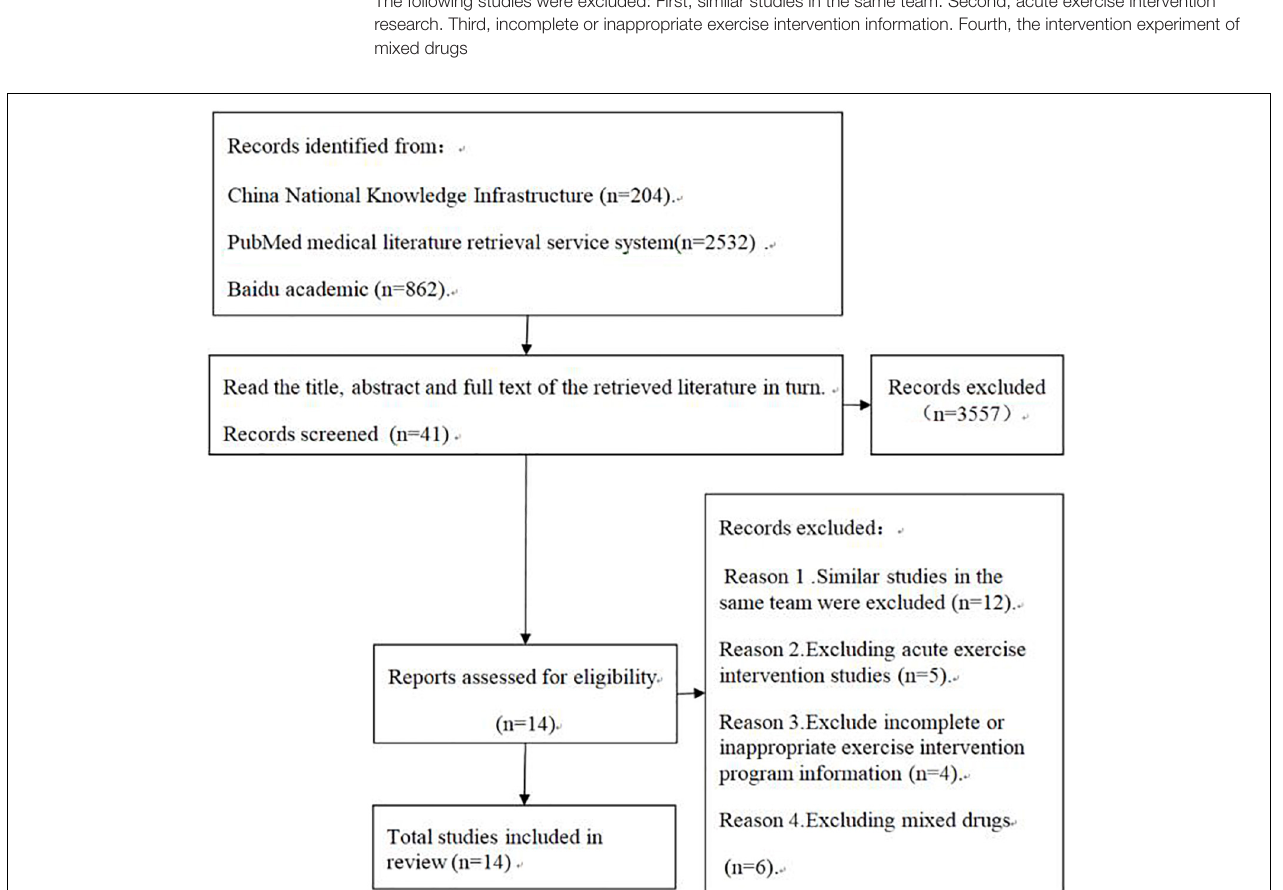
FIGURE 1 | Flow diagram of literature